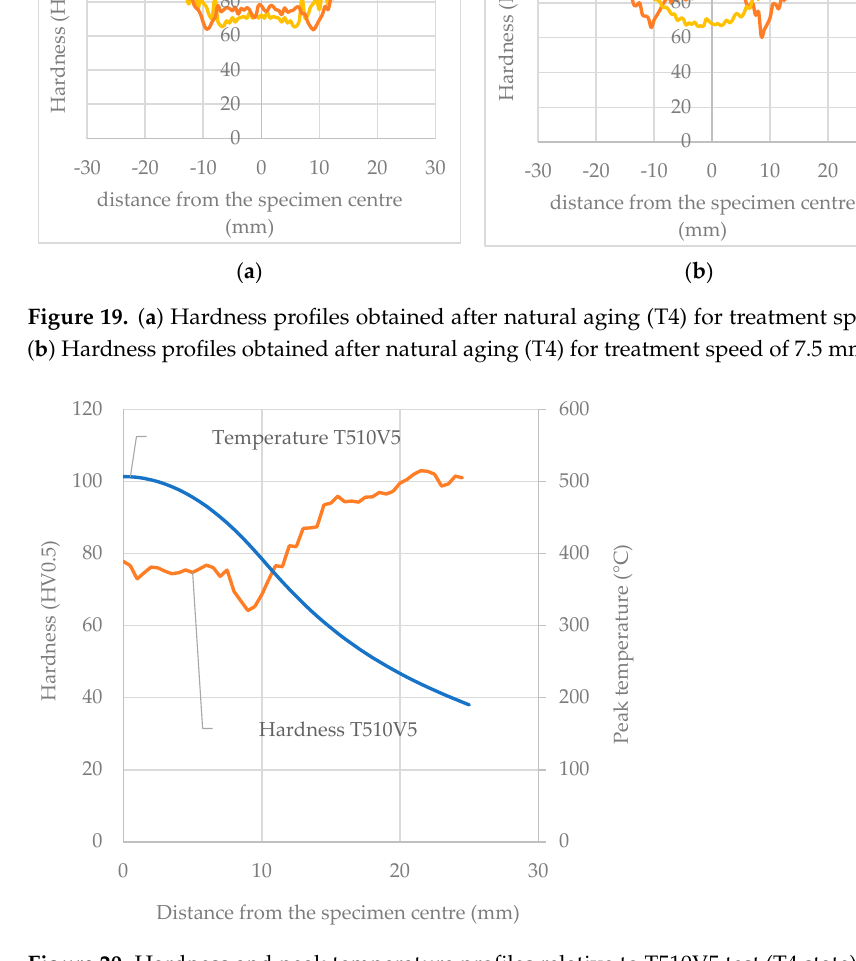
Figure 19. ( a ) Hardness profiles obtained after natural aging (T4) for treatment speed of 5 mm/s; ( b ) Hardness profiles obtained after natural aging (T4) for treatment speed of 7.5 mm/s.